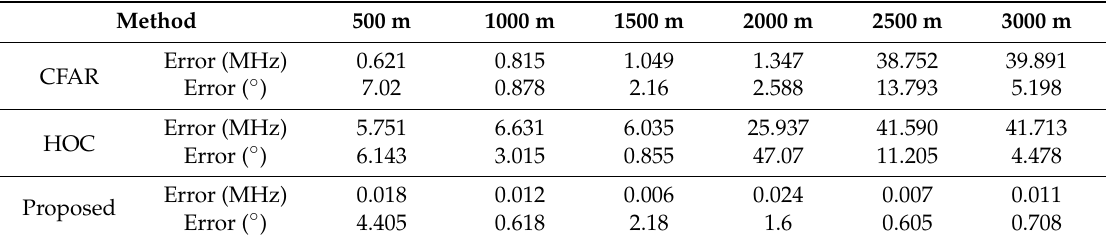
Table 2. Parameter estimation errors for UAV detection using three methods in an outdoor environment. CFAR: constant false alarm rate; HOC: higher-order cumulant.